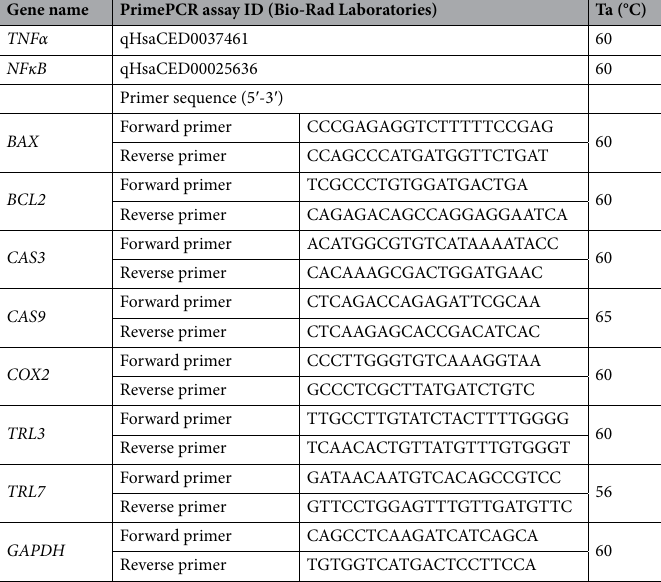
Table 1. The detail of primers used for